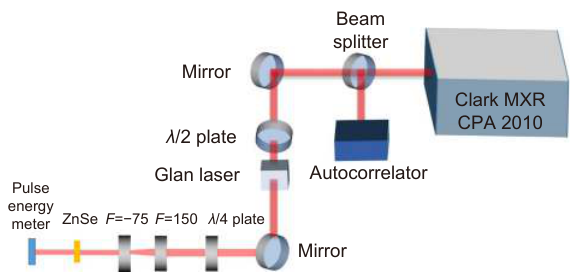
Fig. 1 | Schematic diagram of experimental set up for NL trans- mission measurements. An attenuated and de-magnified beam is directed to the ZnSe substrate where the external transmission can be measured. A λ /4 plate allows incident polarisation to be altered from linear to circular.